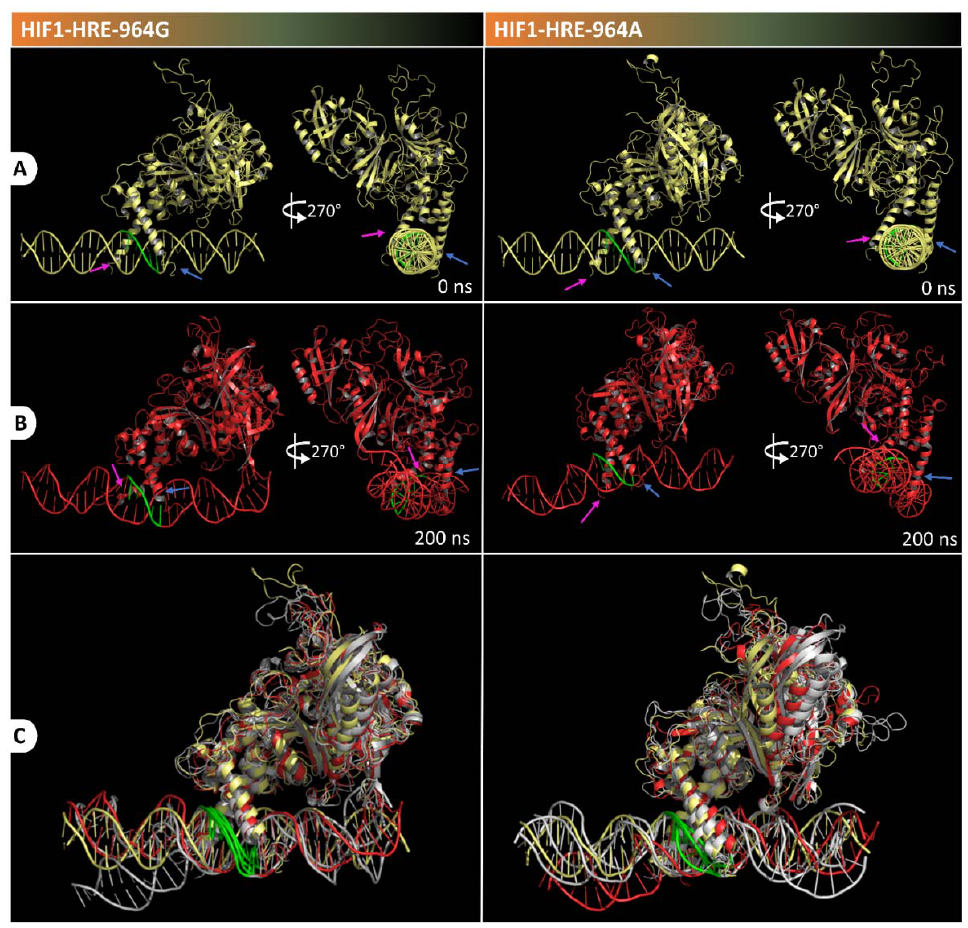
Figure 7. Visualization of trajectory snapshots at times 0 ( A ) and 200 ns ( B ) for the HIF1-HRE-964G and HIF1-HRE-964A complexes. In the Figure ( C ) is illustrated the structure superposition at specific times (0, 50, 150, and 200 ns) of the trajectory for the HIF1-HRE964G/A complexes, in which the initial structure is illustrated in yellow, the time final structure is illustrated in red, and other structures are illustrated in gray. The blue and pink arrows indicate the α -helix 1 region of the ARNT and HIF1a subunits, respectively. The HRE is highlighted in green in the DNA structure. Note: Author's own image.